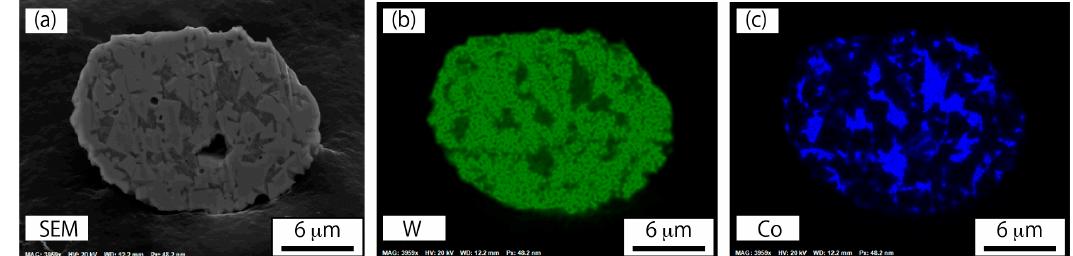
Figure 9. Elemental mappings on a cross-section for a plasma-treated WC–12%Co particle: ( a ) SEM image, ( b ) tungsten mapping, and ( c ) cobalt mapping.